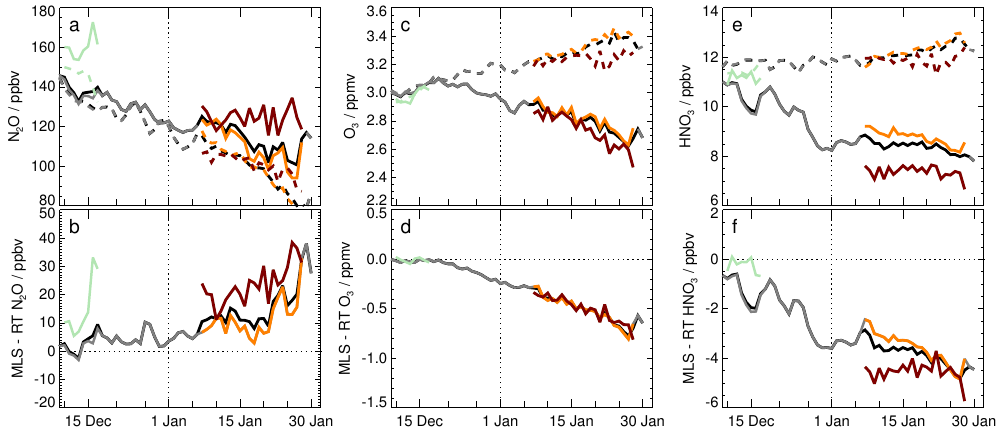
Figure 13. Vortex-averaged (left to right) N 2 O, O 3 , and HNO 3 from MLS (solid lines) and RT passive subtraction (dashed lines) calculations (see text) at 490K from 8 December 2012 through January 2013. (a) , (c) , and (e) show mixing ratios in each of the vortices present; (b) , (d) , and (f) show the difference between MLS and RT (passively transported) values, indicative of transport uncertainties for N 2 O, and chemical and/or microphysical changes for O 3 and HNO 3 . Line colors are as in Fig.